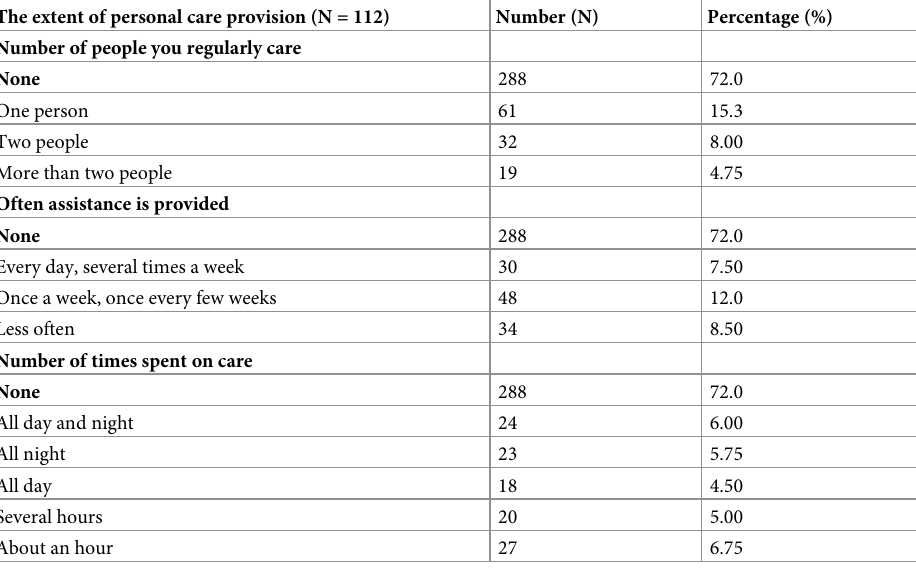
Table 3. Extent of which older adults provides personal care.